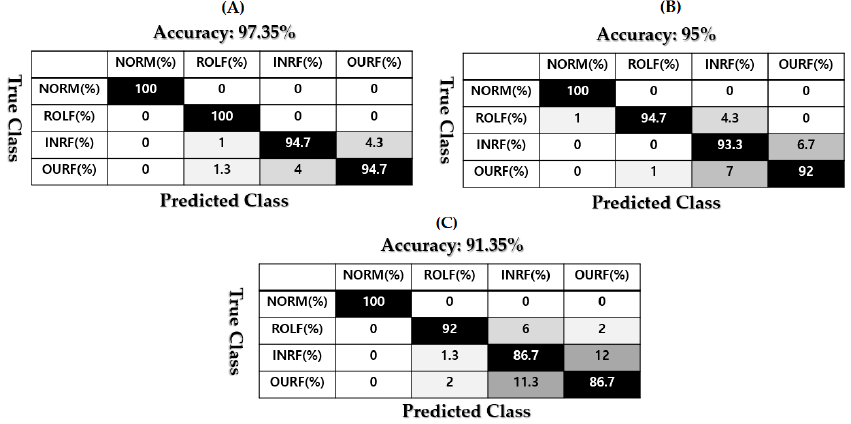
Figure 11. The average fault identification accuracy based on ( A ) the proposed AMRXU- AVSPMI+SVM, ( B ) AMRXU-VSPMI+SVM, and ( C ) AMRXU-PMI+SVM (torque load: 2 hp).